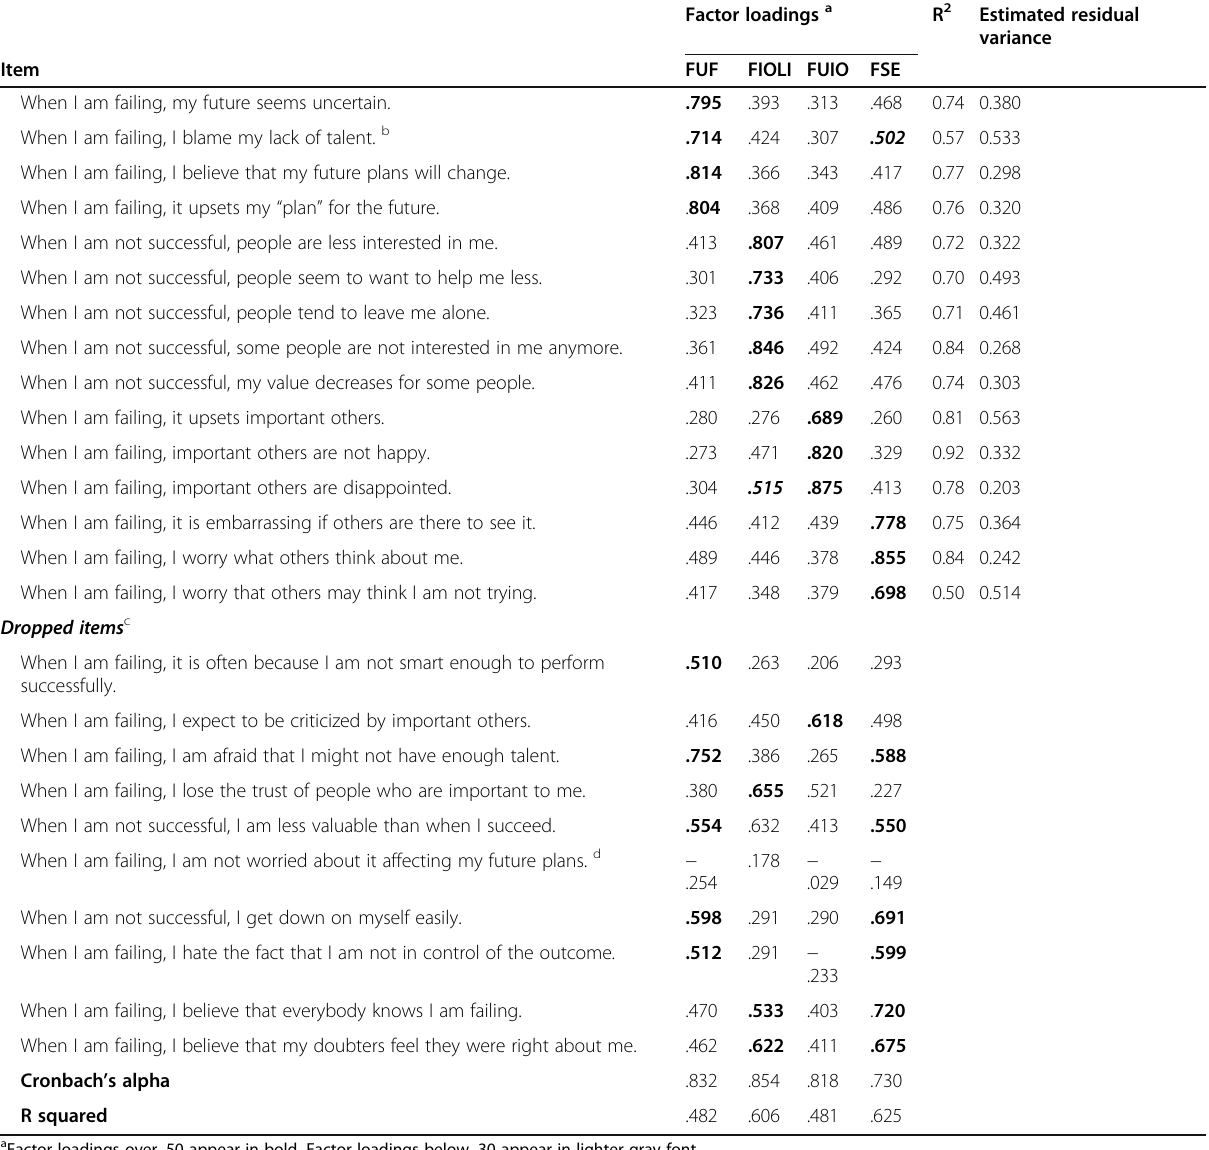
Table 6 Factor loadings for four-factor model of PFAI